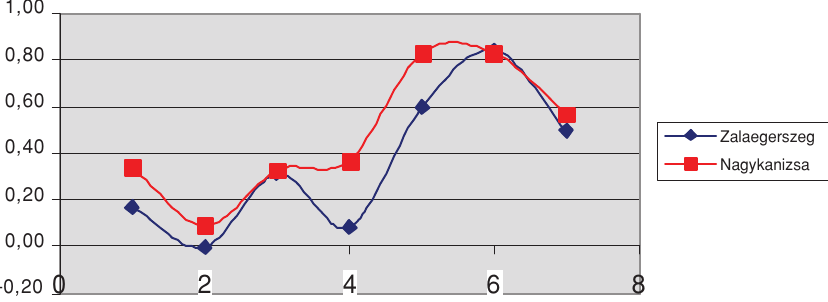
Figure 5. Risk of fruit crack damage by the week of harvest period (25. May – 10.